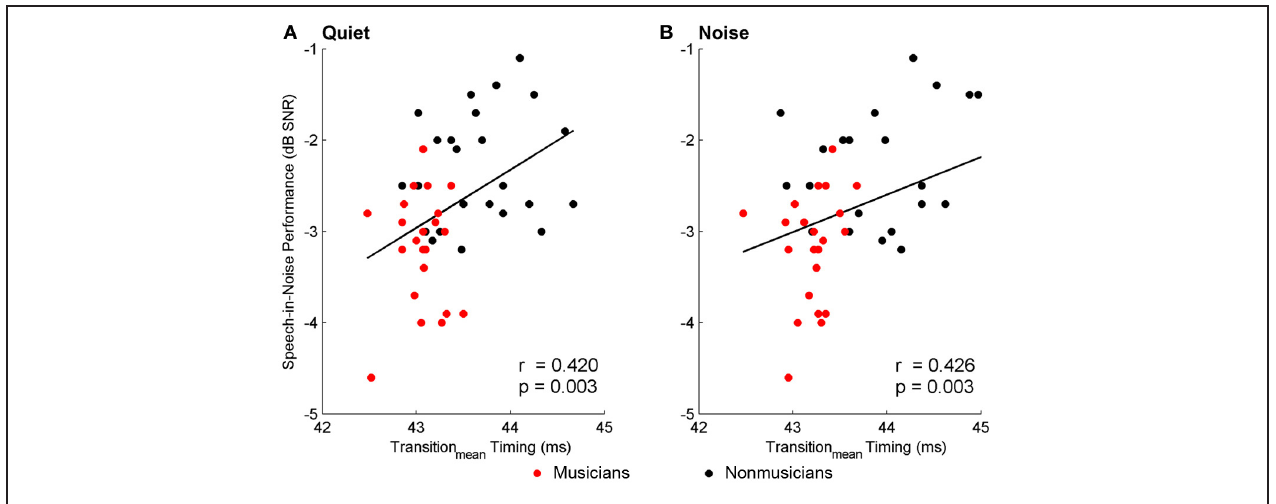
(not plotted here) were found for the neural response timing to the onset and the vowel; see text for more details. A lower, more negative speech-in-noise score is indicative of better